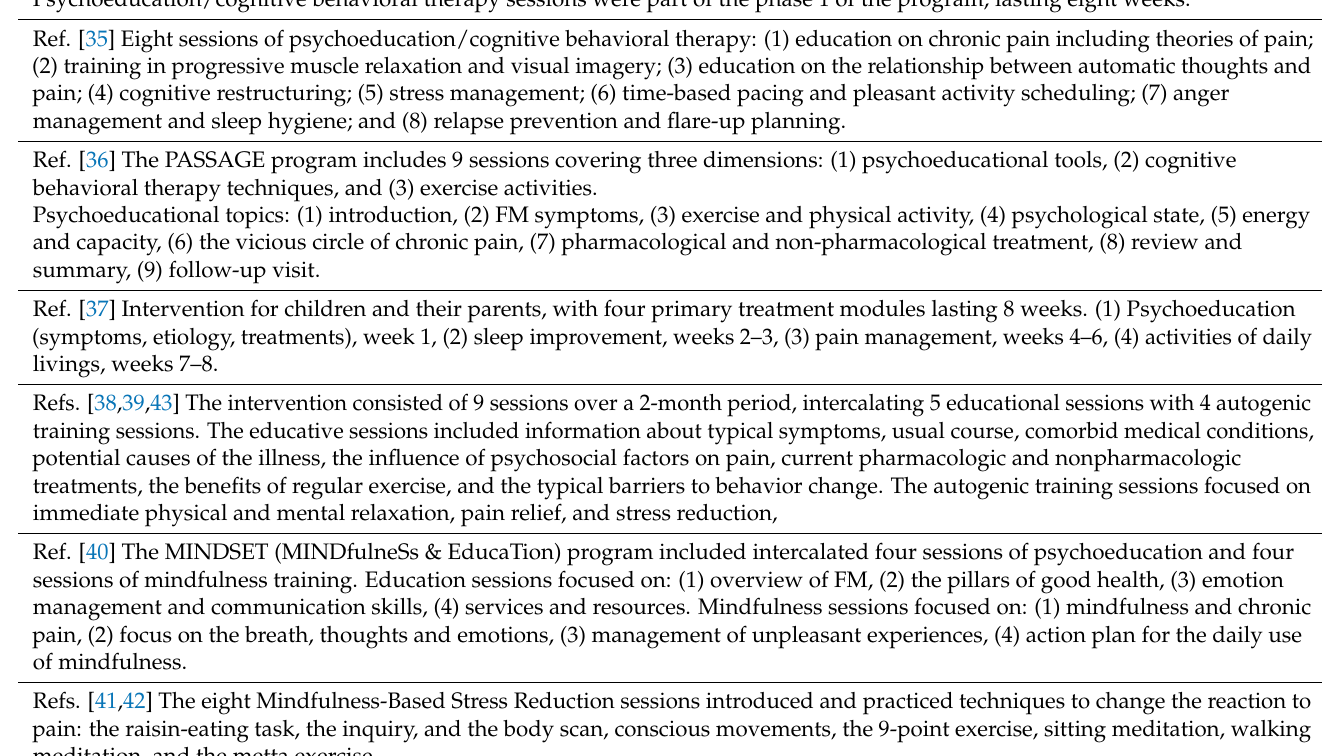
Table 4. Outline of the